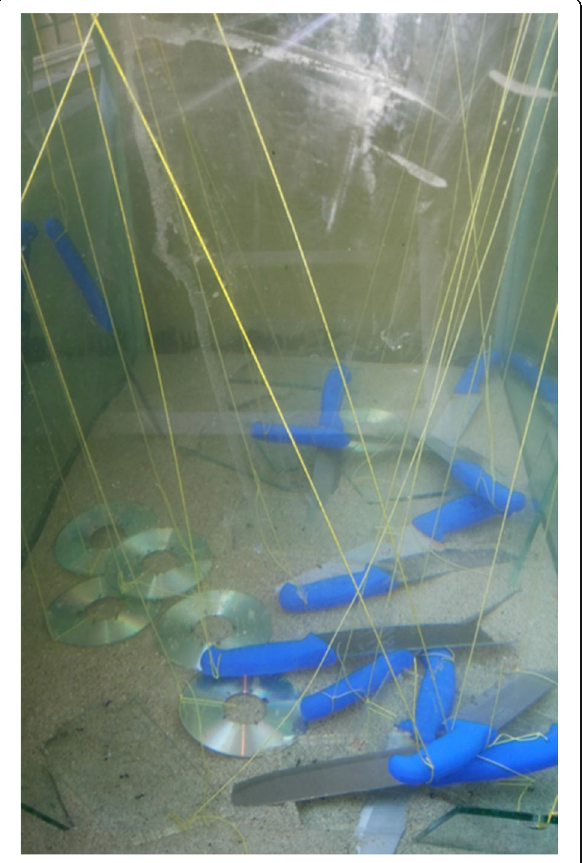
Fig. 1 non porous surfaces were placed in aquarium tank filled